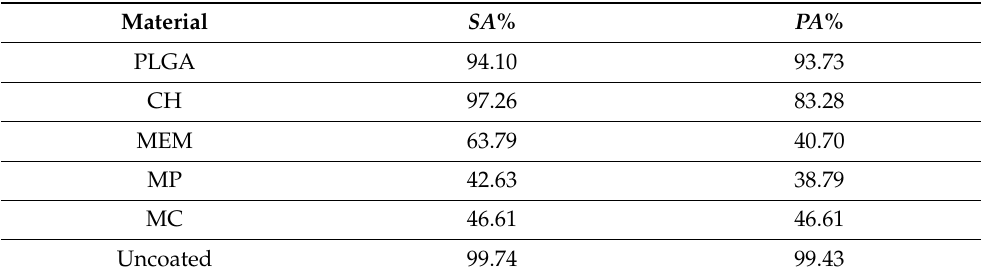
Table 4. Showing the Percentages of live bacteria among the different materials against SA and PA using the confocal microscope.